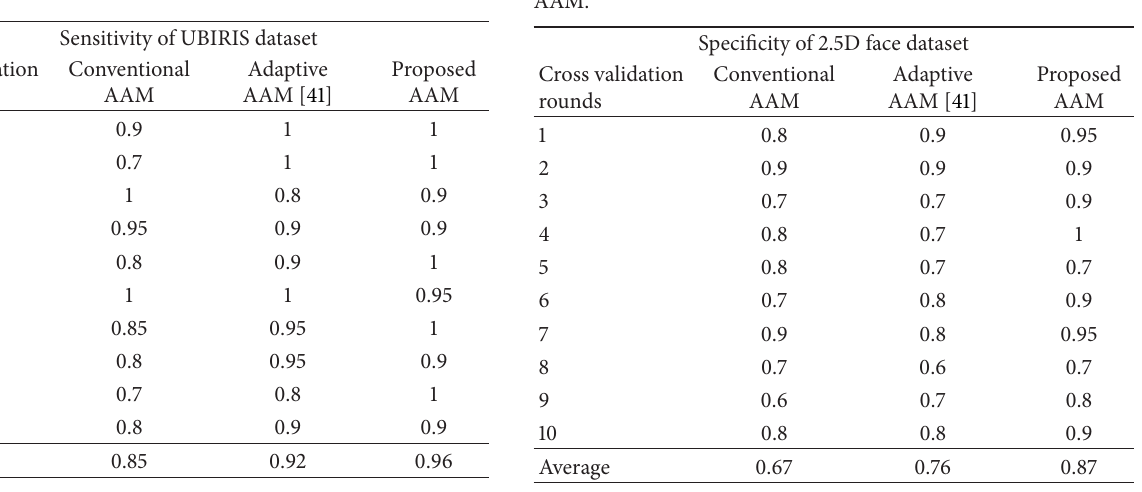
Table 8: Cross validation results for UBIRIS dataset in terms of sensitivity for conventional AAM, adaptive AAM, and the proposed AAM.